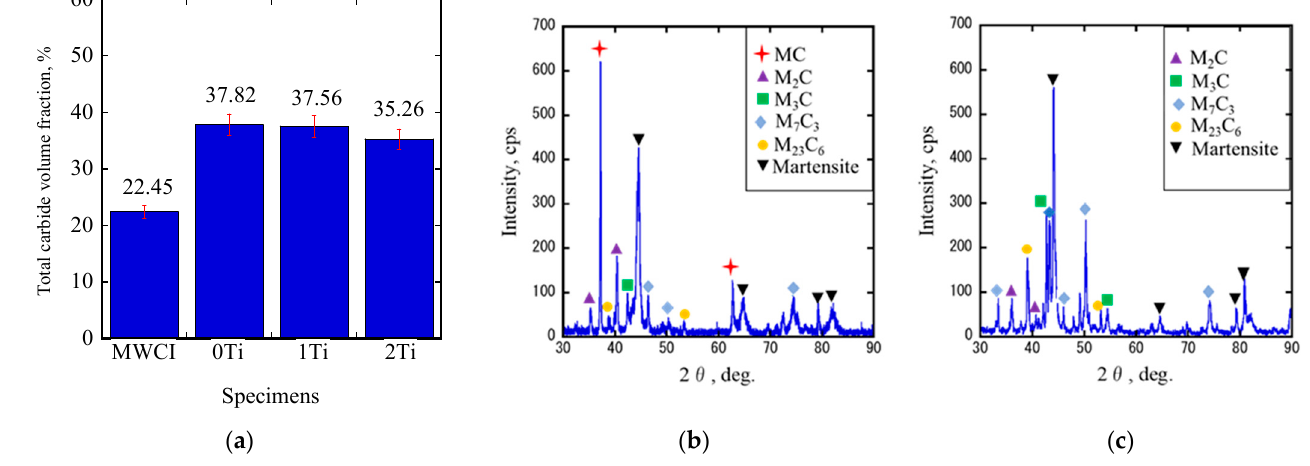
Figure 7. ( a ) Total CVF of each material; XRD patterns of ( b ) MWCI and ( c ) 0Ti.